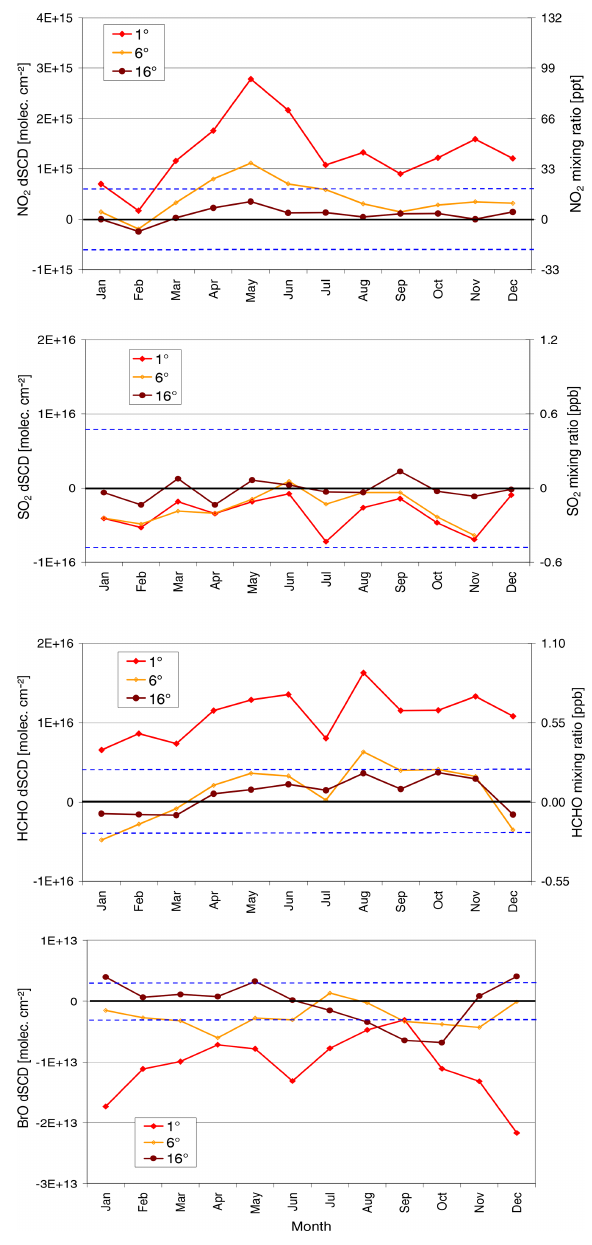
Figure 8. Seasonal means of the trace gas dSCDs for different el- evation angles for clear sky and low aerosol load. For NO 2 , SO 2 , and HCHO the right axes represent the approximate mixing ratios for measurements at a 1 ◦ elevation angle. The blue dotted lines indi- cate the systematic uncertainties, which can be considered the lower bound of the detection